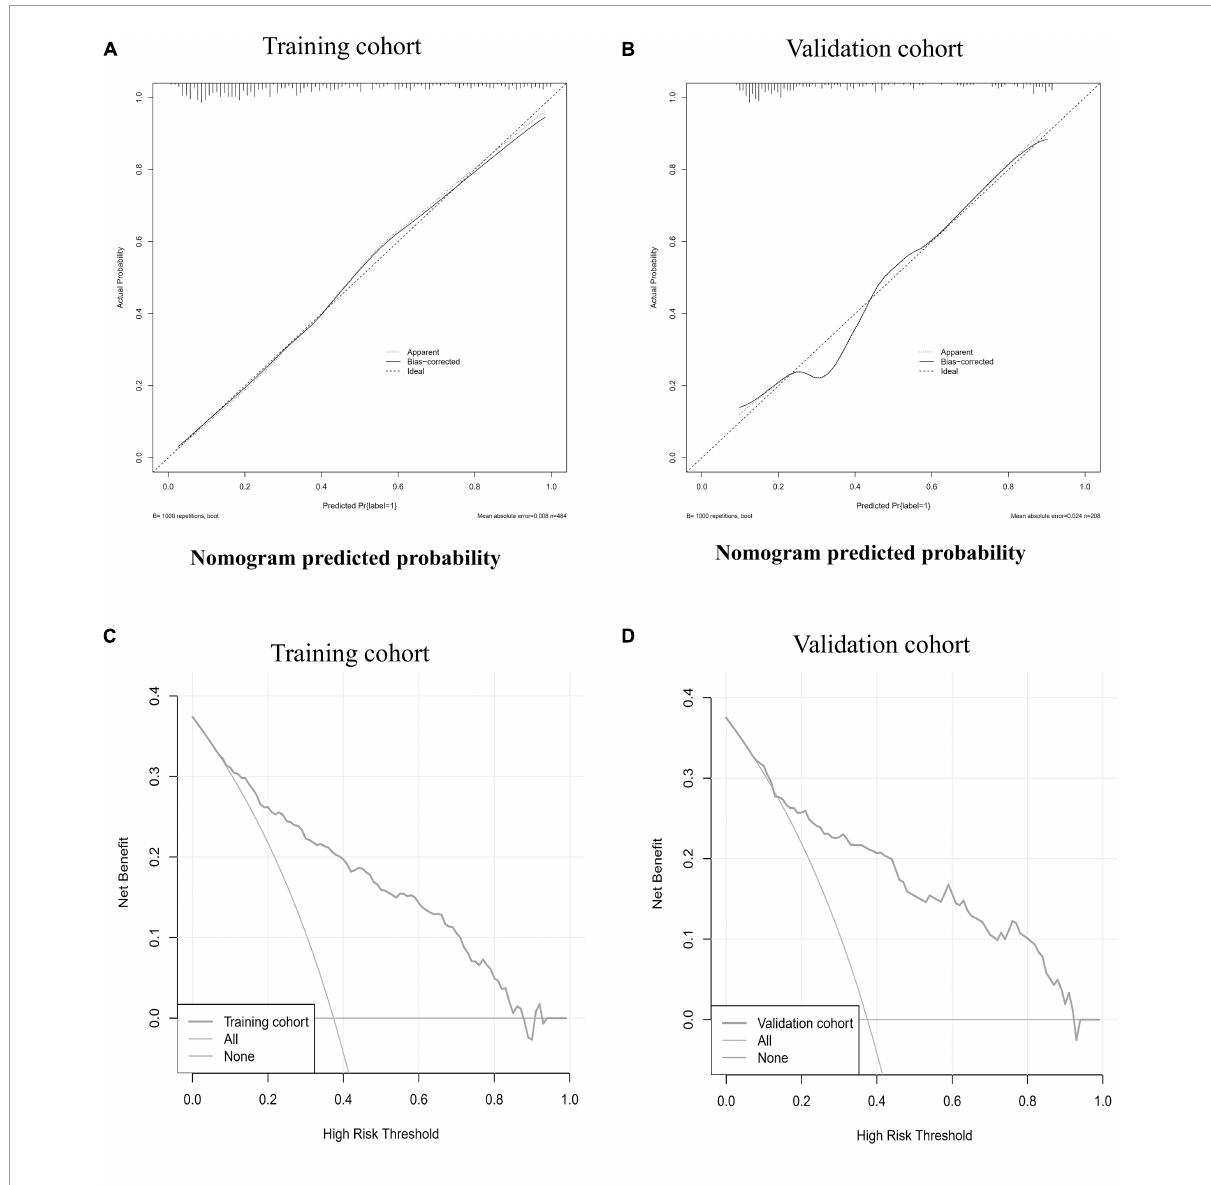
FIGURE3 The calibration curve and decision curve of the nomogram in training and validation cohorts. The calibration curves of the nomogram in the training cohort (A) and validation cohort (B) are reported. The x-axis is the nomogram predicted probability and the y-axis is the actual probability. The prediction performance can be measured by the difference of the fitted curve and slope 1 line (diagonal 45-degree line). The diagonal dotted line represents a perfect prediction by an ideal model. The solid line represents the performance of the nomogram, of which a closer fit to the diagonal dotted line represents a better prediction. Decision curve analysis for the nomogram in the training cohort (C) and validation cohort (D) are showed. The y-axis measures the net benefit. The red line represents the nomogram. The blue line represents all patients had MACE. The orange line represents the assumption that no patients had MACE. The decision curve showed that if the threshold probability of a patient uses the nomogram offered a net benefit over the “happen-all” or “happen-none” strategy at a threshold range form 8–88 to 8–92%, respectively in the training cohort and validation